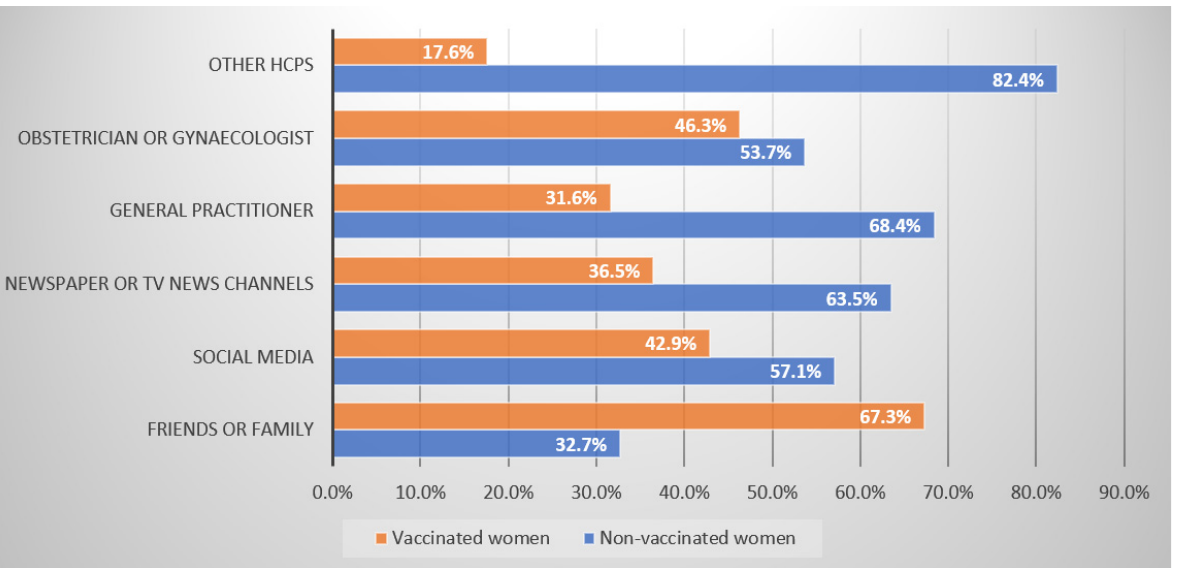
Figure 1. Sources of information about COVID-19 vaccines in vaccinated and non-vaccinated women.